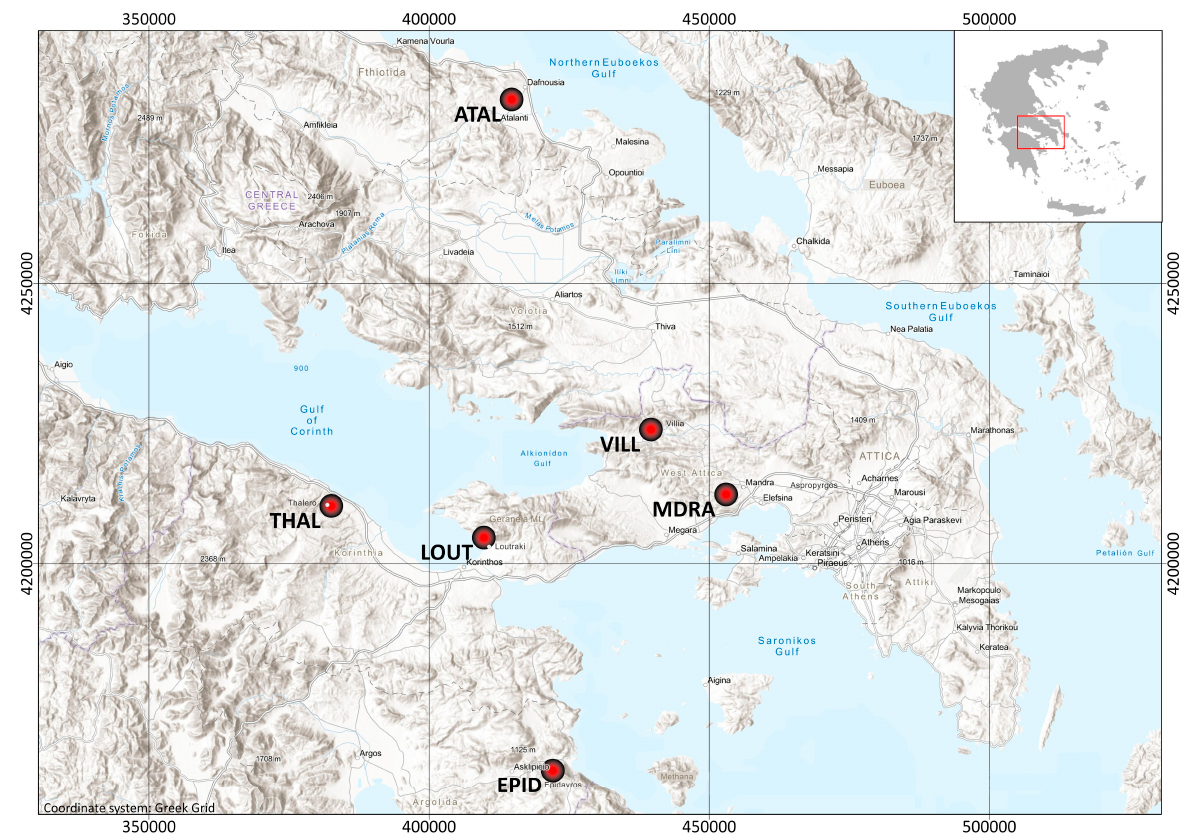
Figure 1. Locations of the investigated areas and selected seismological stations (red circles).